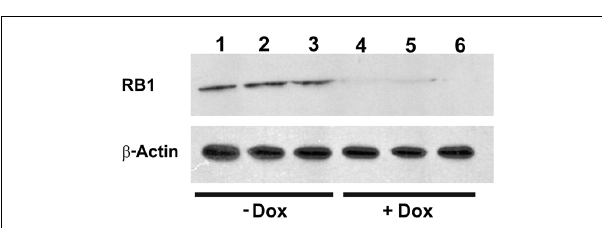
FIGURE 6 | Dox-mediated DN-CBRb activation is tightly regulated by Dox administration. Cochleae of Dox treated (lanes 1–3) and untreated (lanes 4–6) P10 DN-CBRb + / ROSA-CAG-rtTA + mice were submitted to Western blot analysis with anti-RB1 antibody. Consistent with a tight regulation of the DN-CBRb expression by Dox administration, no endogenous RB1 expression was observed on DN-CBRb + / ROSA- CAG-rtTA + mice cochleae in the presence of